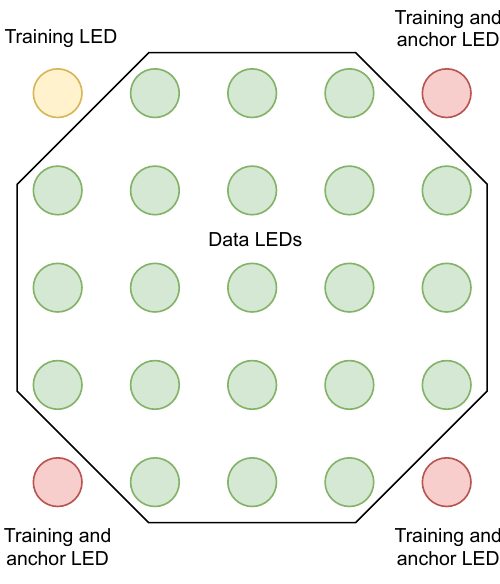
Figure 2. Transmitter LED data